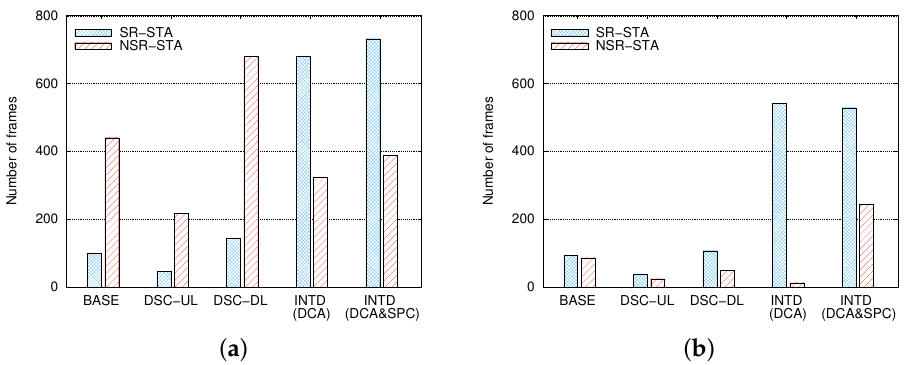
Figure 10. Comparison of numbers of frames ( a ) transmitted to SR-STAs and NSR-STAs and ( b ) successfully delivered to SR-STAs and